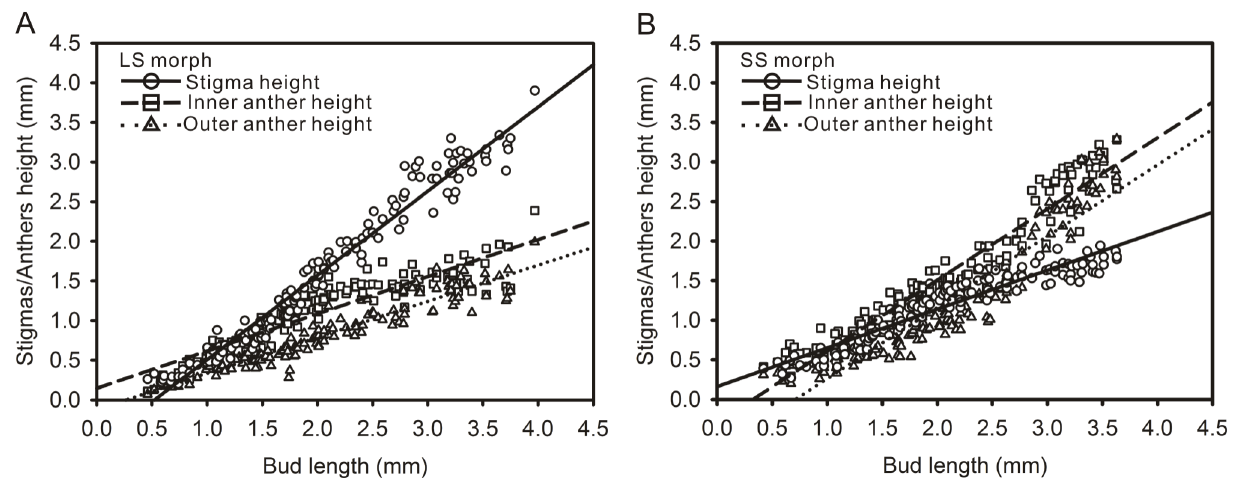
Figure 2. Floral organ heights in flowers of two morphs during floral development of Polygonumjucundum . A, the long-styled flower; B, the short-styled flower. Regression lines were fitted separately to data for each floral organ.